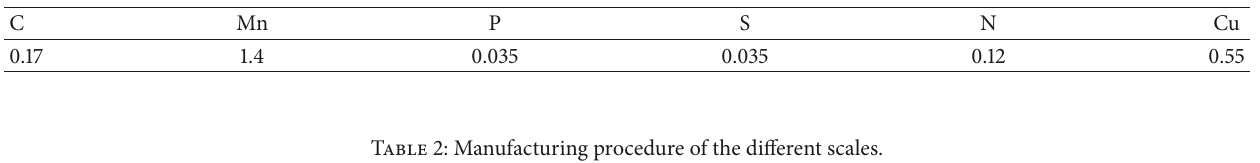
Table 1: Chemical composition of the steel bars (% mass).